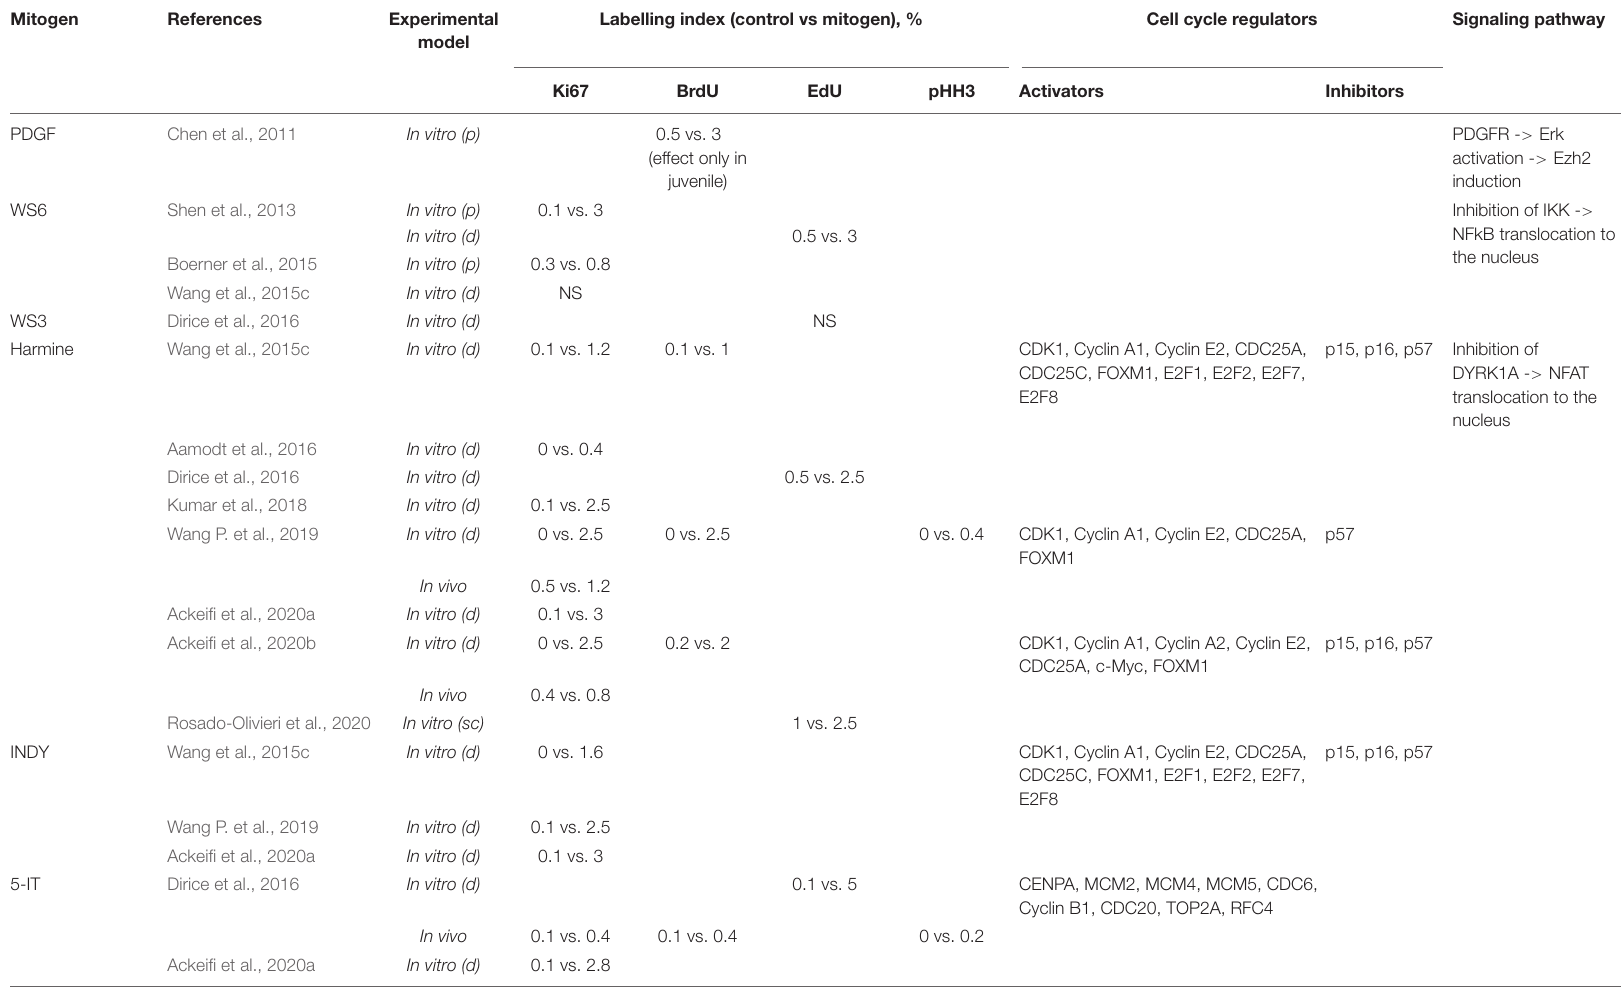
TABLE 1 | Human beta cell mitogens and their potencies.